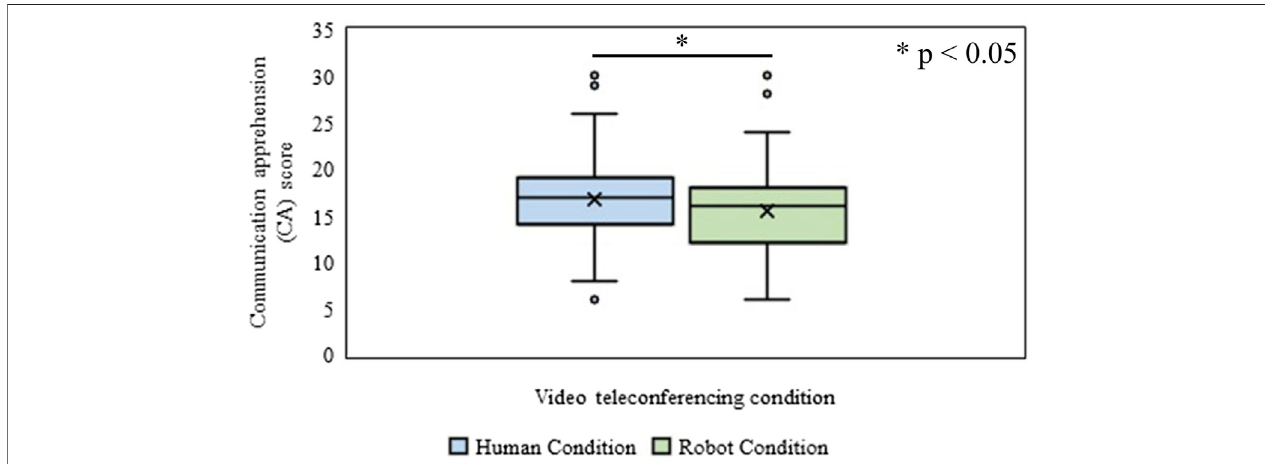
FIGURE 4 | Communication apprehension (CA) in Human and Robot conditions of Experiment- Ⅰ .